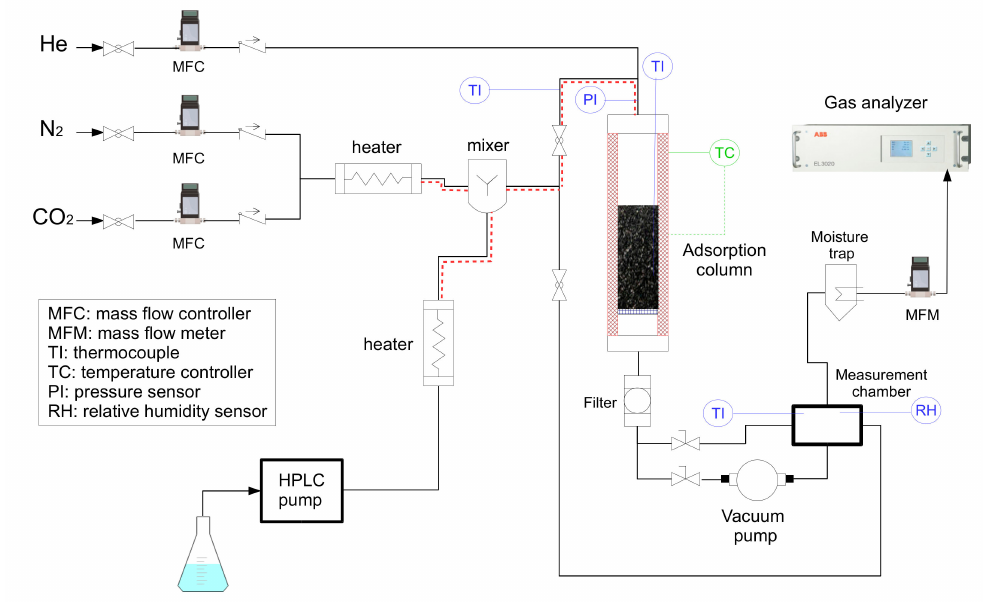
Figure 1. Schematic diagram of the packed-bed setup used for dynamic breakthrough